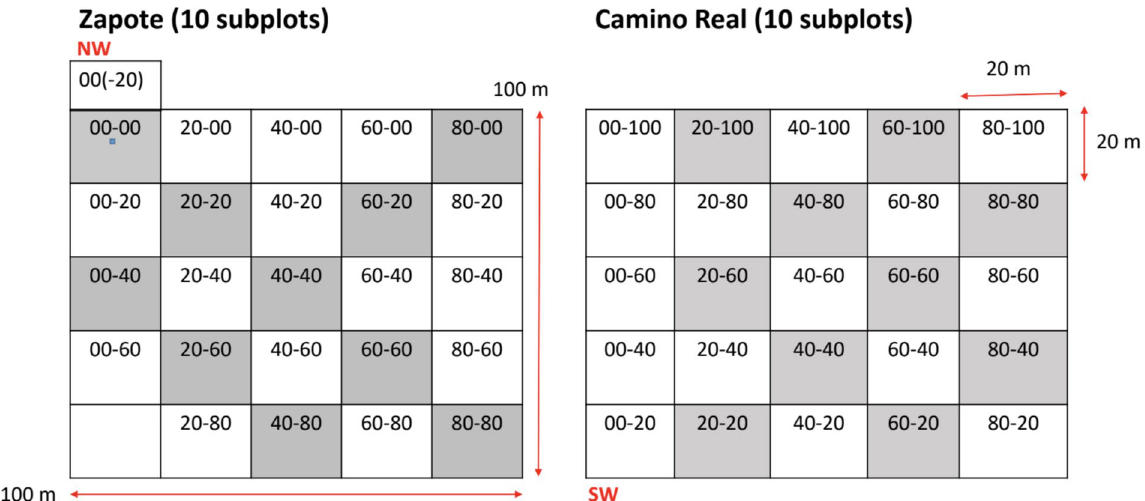
Figure 4. Diagramatic representation of the subplots chosen for this study are the shaded